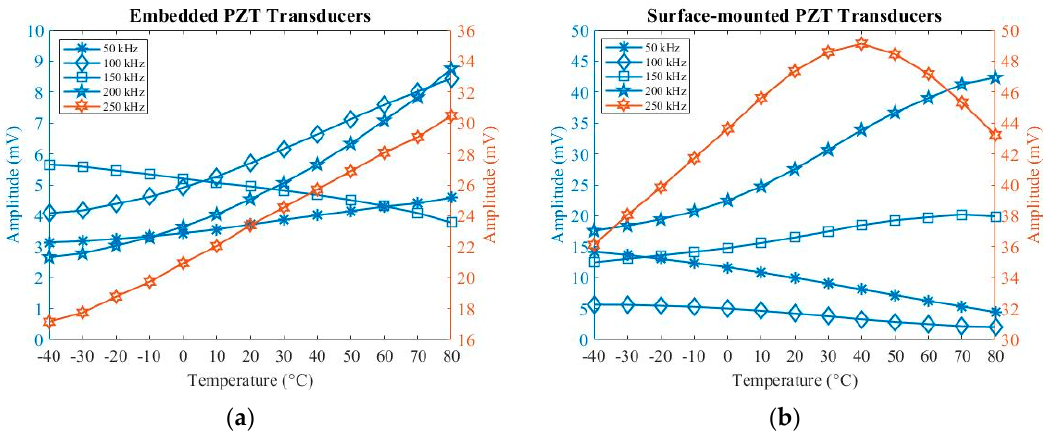
Figure 8. Temperature influences on amplitude for ( a ) embedded and ( b ) surface ‐ mounted signals.